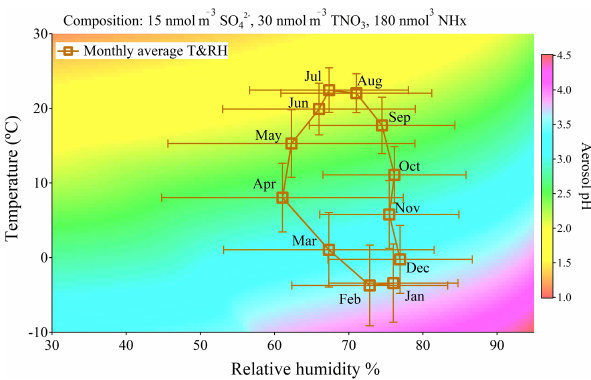
Figure 4. Plot of E-AIM calculated pH under different com- binations of relative humidity (from 30% to 95%) and tem- perature (from − 10 to 30 ◦ C) with the fixed input chemi- cal compositions (15nmolm − 3 sulfate, 30nmolm − 3 TNO 3 and 180nmolm − 3 NH x ). The square plots on the graph represent monthly averages of meteorological parameters in Toronto from 2007 to 2016 with standard deviations as error